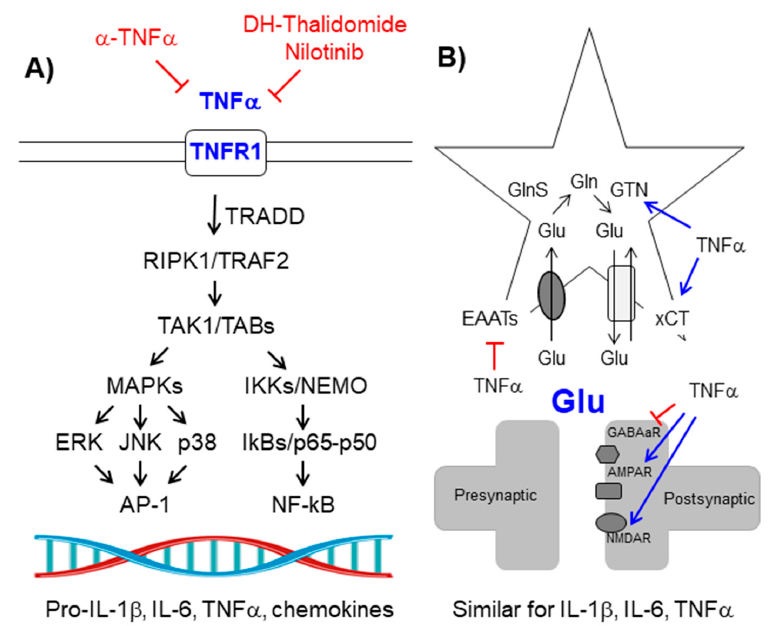
Figure 3. Tumor necrosis factor α (TNF α ) / TNFR1 signaling pathway. ( A ) Schematic view of the components of the signaling pathway. See text for details. Components of the pathway that are increased in epilepsy are in blue. Therapeutic strategies to prevent the pathway are in red. ( B ) TNF α enhances neuronal glutamatergic transmission: On the one hand, it increases the levels of glutamate (Glu), and on the other hand, it enhances the activity of postsynaptic glutamate receptors. See the text for details. Pointed arrows indicate direction of the signaling pathway. Blunt arrows indicate inhibition.